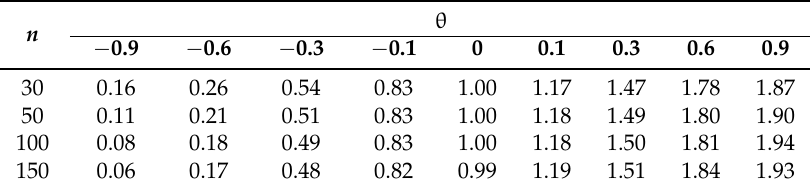
Table 2. Variance inflation factor V ( ρ )/ var ( ρ ) for MA(1) model.